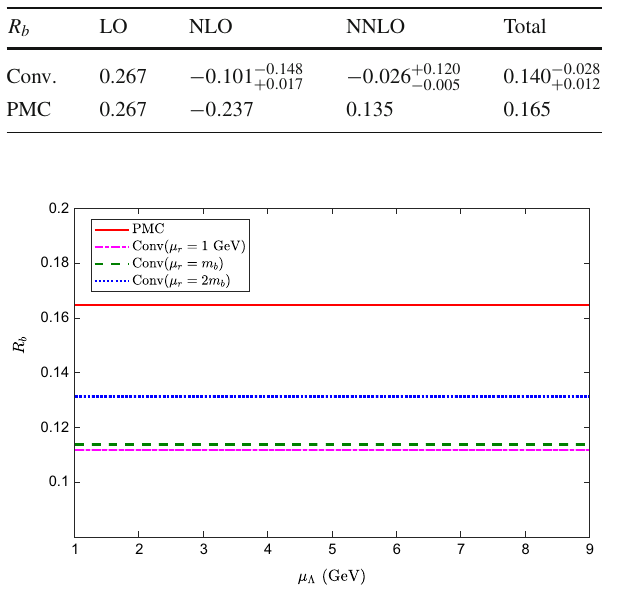
and Fig. 5. To do the numerical calculation, we take the b - quark pole mass m b = 4 . 78 GeV [46]. Due to α s ( m b ) ∼ 0 . 1, a better pQCD convergence is observed for the bottomonium case, and the scale uncertainty is smaller, i.e. the net NNLO scale error is about 29% for μ r ∈ [ 1 GeV , 2 m b ]